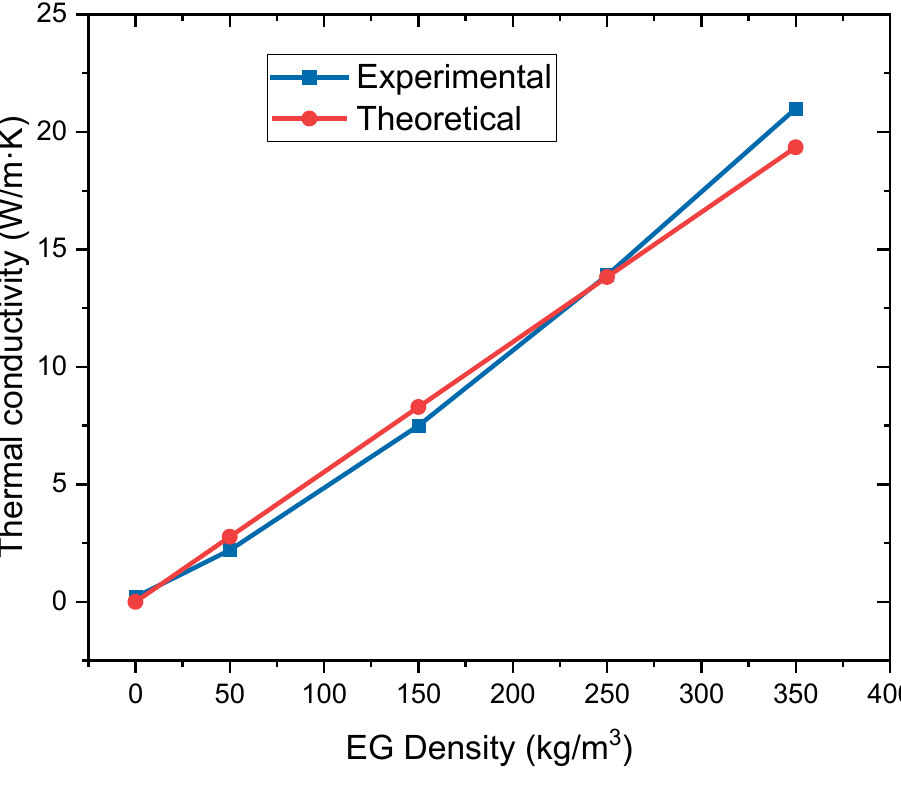
Figure 10. Validation of the thermal conductivity model.